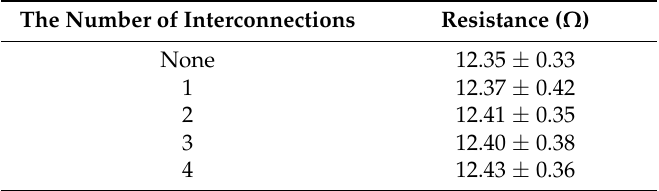
Figure 4. ( a ) Cross-sectional SEM image of the interconnected region between the top and bottom Ag electrodes; ( b ) schematic of cross-sectional sample structure fabricated by selective laser sintering (SLS) and selective laser ablation (SLA). Table 1. The measured resistances (mean ± standard deviation) according to the number of interconnections. The Number of